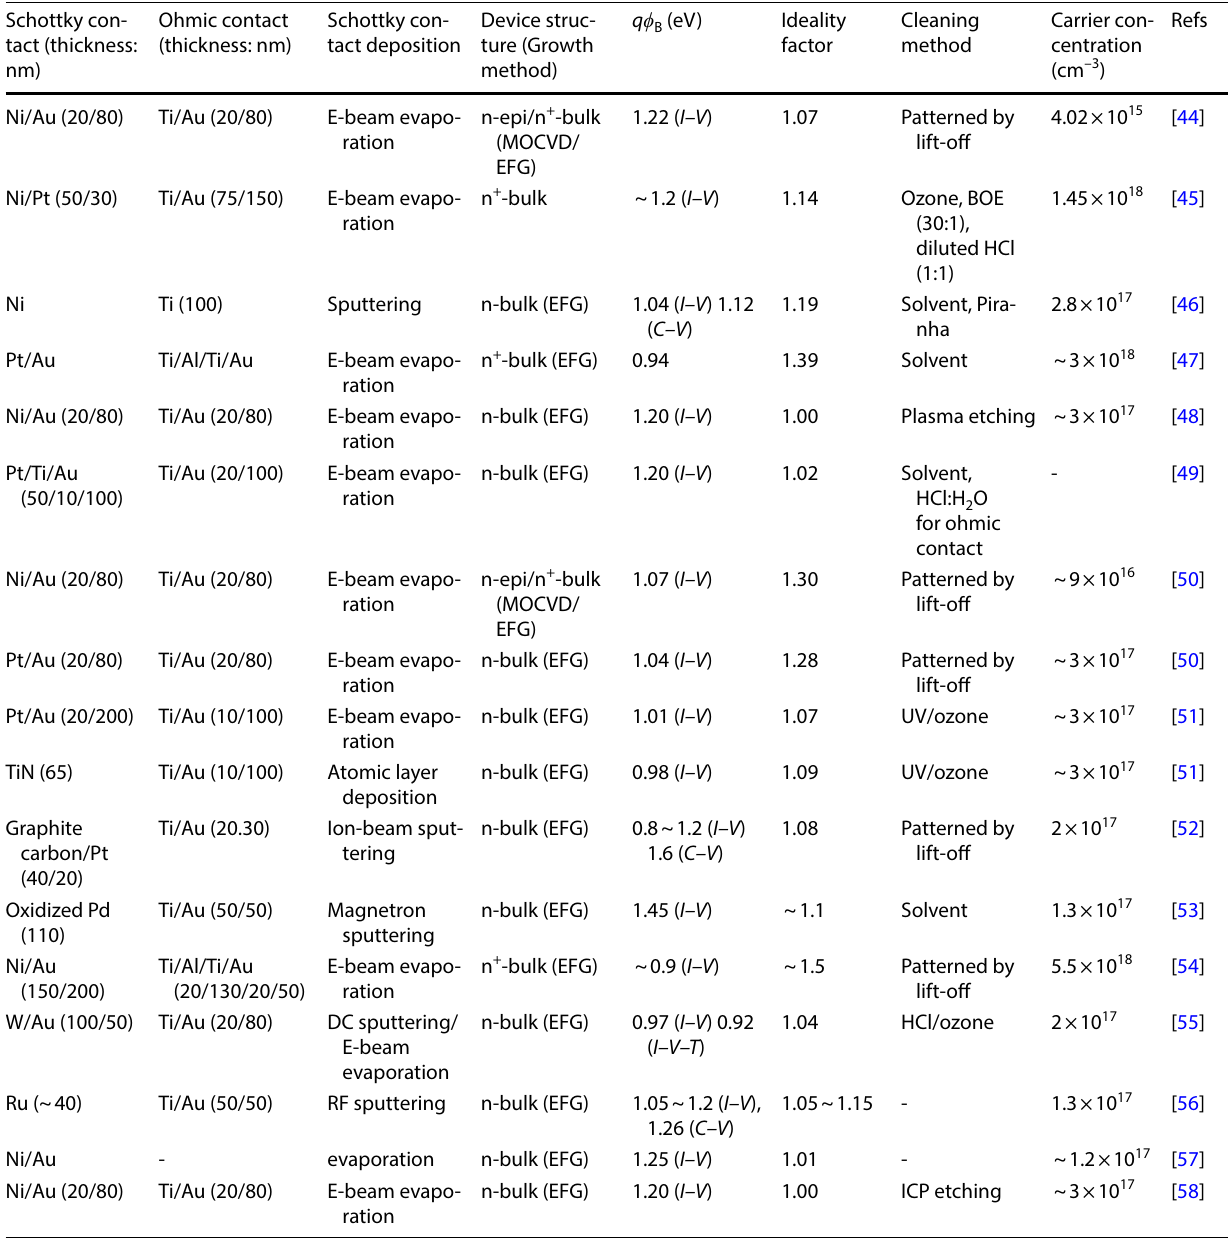
O reported in the literature 2 3